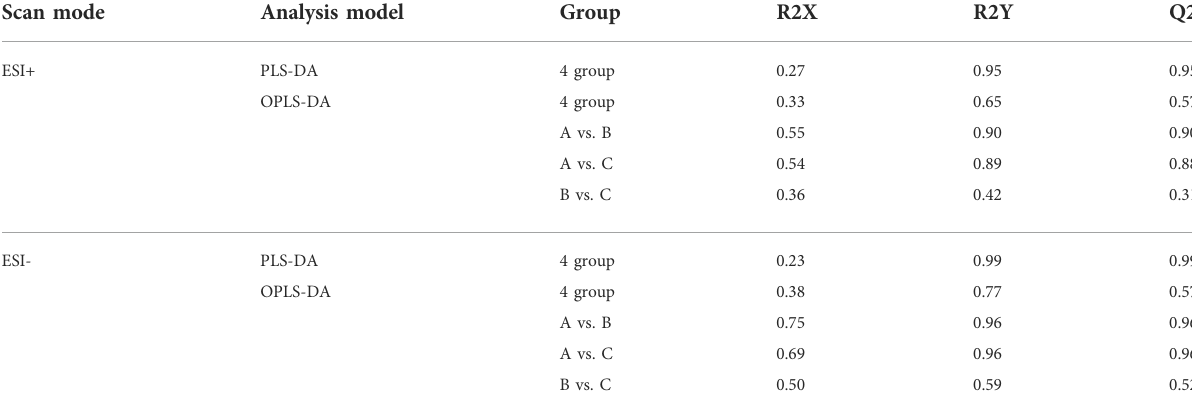
TABLE 2 Comparisons among groups under ESI+ and ESI- scan modes using PLS-DA and OPLS-DA analysis